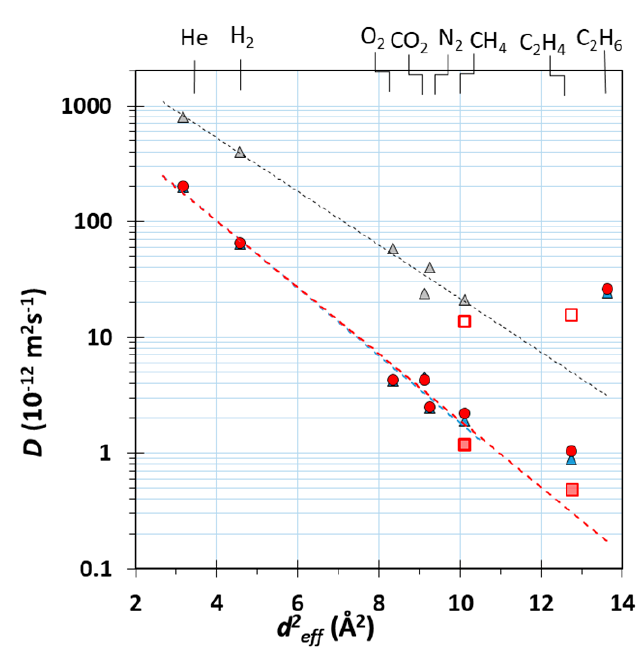
Figure 7. Correlation of the effective diffusion coefficient as a function of the molecular diameter of H 2 , He, N 2 , O 2 , CH 4 , CO 2 , C 2 H 4 , and C 2 H 6 for neat Pebax ® 1657 (grey triangle, ) and the Pebax ® 1657/ Cu II2 (S,S) ‐ hismox MMMs calculated via the tangent method (blue triangle, ) and the fitting procedure (filled circle, ). Filled square symbols ( ) indicate the slow term, and open square symbols ( ) indicate the fast term of the fit with two different effective diffusion coefficients.